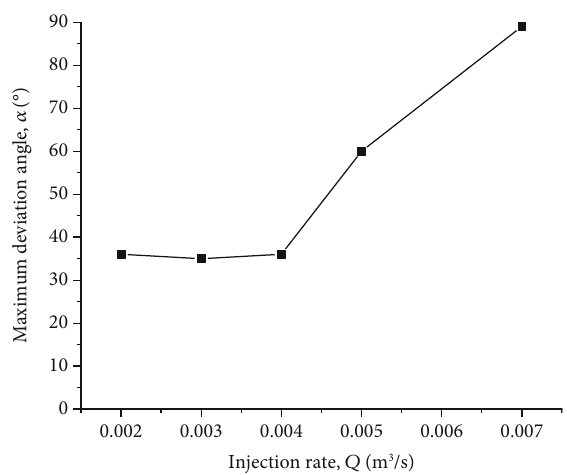
Figure 13: Variation of the maximum deviation angle for di ff erent injection